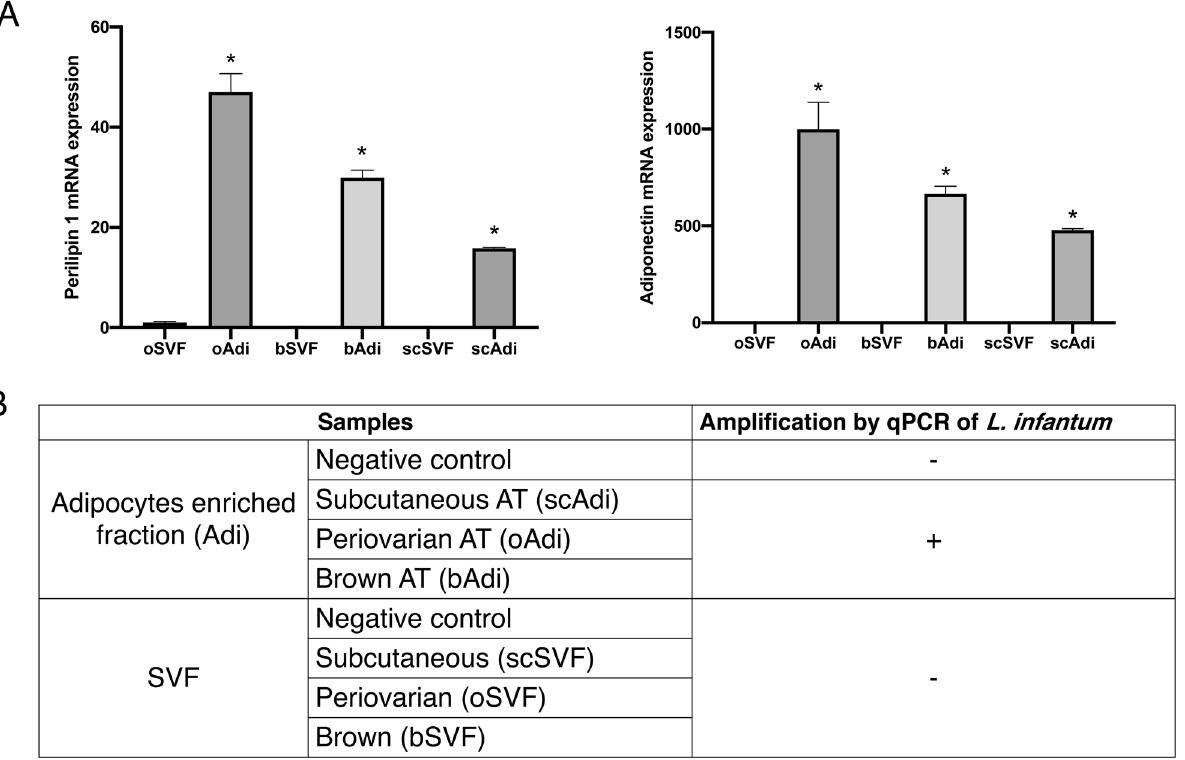
Figure 3. ( A ) mRNA expression of Perilipin 1 and Adiponectin determined by RT-qPCR in the stroma vascular fraction (SVF) and the adipocyte fraction from scAdi, oAdi and bAdi of BALB/c mice in brown and white adipocytes (subcutaneous and periovarian) and stromal vascular fractions. Perilipin-1 and Adiponectin mRNA expression were used as a control for adipocyte purification. Histograms represent mean + sem of 4 mice. ( B ) Detection by qPCR of Leishmania infantum in adipose tissue fractions. DNA was extracted in a 100 µL volume and the presence of L. infantum DNA was determined by qPCR using a 2.5 µL DNA extract. *p <